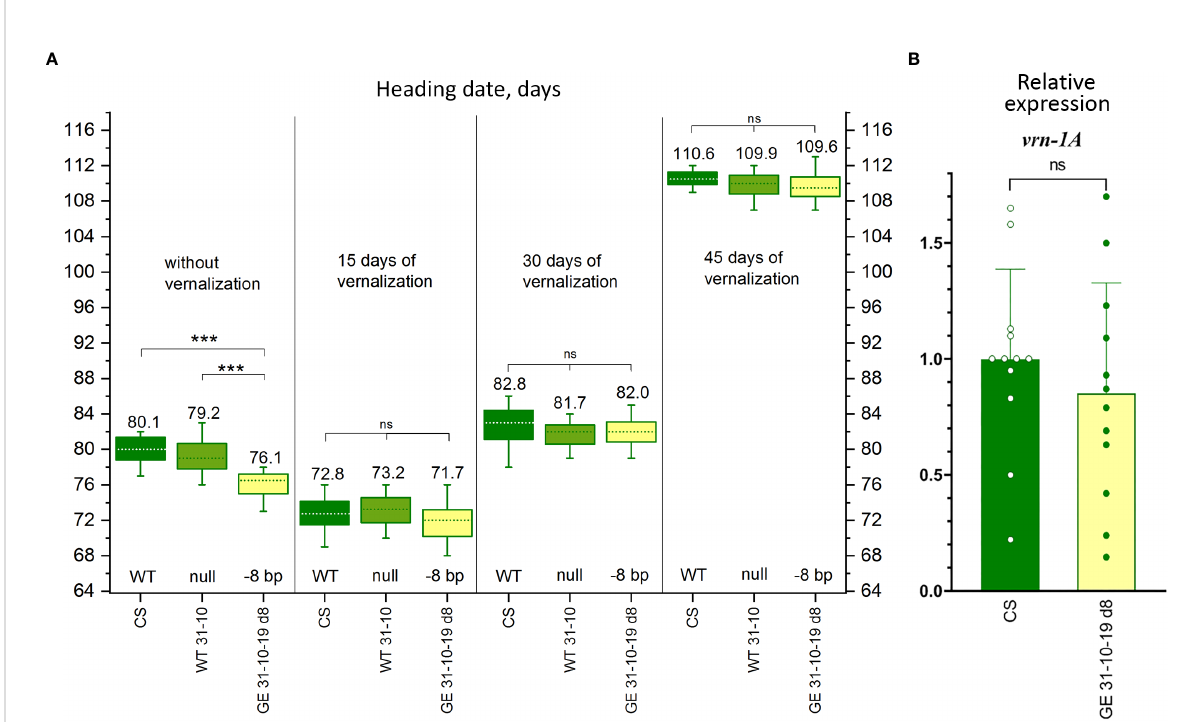
FIGURE 5 Characterization of the genome-edited wheat line carrying the 8 bp deletion in the promoter region of vrn-A1. (A) Effect of vernalization on the heading date of wheat plants carrying the 8 bp deletion (GE31-10-19 d8) in comparison with the ‘ Chinese Spring ’ plants and transgene-free null-segregant plants (WT31-10). NS: nonsigni fi cant. (B) Relative expression of the vrn-1A gene in wheat plants carrying the 8 bp deletion in the promoter region of vrn-A1 (GE31-10-19 d8) in comparison with the ‘ Chinese Spring ’ (CS) plants; Tukey ’ s multiple comparisons test, *** p < 0.001; ns: nonsigni fi